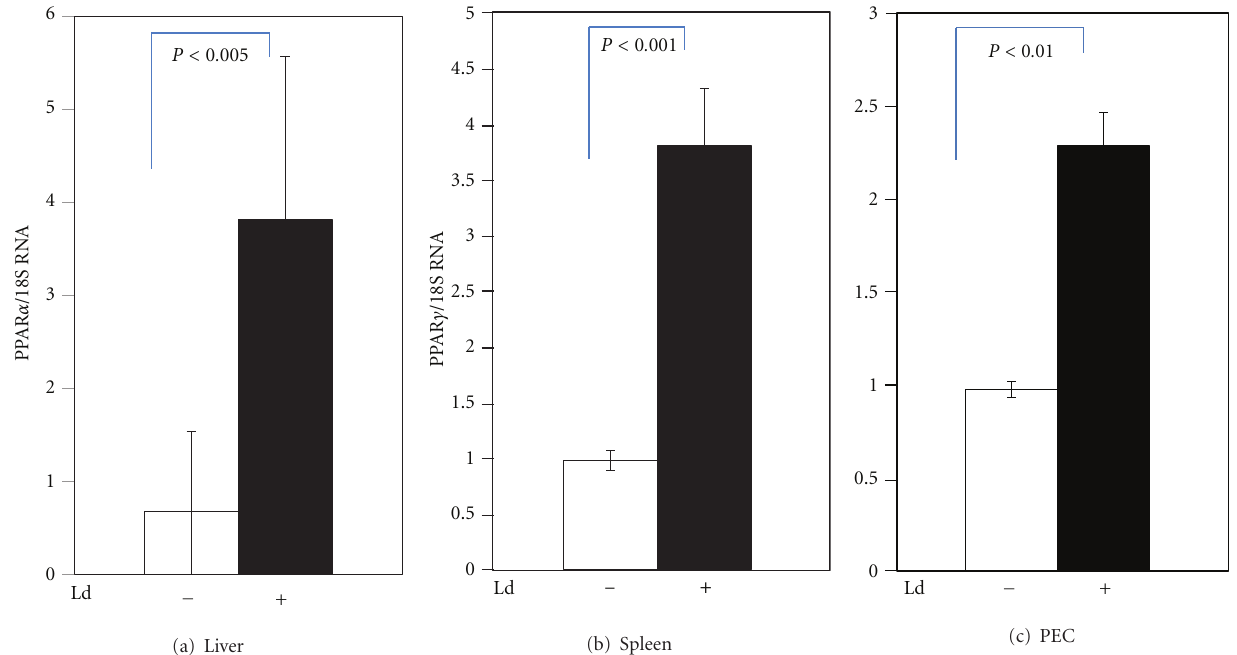
Figure 1: Leishmania infection activates PPAR gene expression. In (a) and (b), BALB/c mice were infected i.v. with 10 7 stationary phase promastigotes of L. donovani for 4 weeks, and then liver and spleen, respectively, were harvested. In (c), peritoneal exudate cells (PECs) were obtained from the peritoneum of normal BALB/c mice, infected with L. donovani at 1 : 10 ratio, and then harvested for RNA isolation after 2 days. PPAR activation was measured by real-time RT-PCR with normalization to 18S or actin RNA, and modulation was compared and expressed relative to the uninfected control using the delta-delta Ct method. The infected groups (black bars) showed higher levels of gene expression in liver (a), spleen (b), and PECs (c) in comparison to uninfected controls (open bars). Statistical analysis was performed by Mann-Whitney U test, and a P value of less than 0.05 was considered as